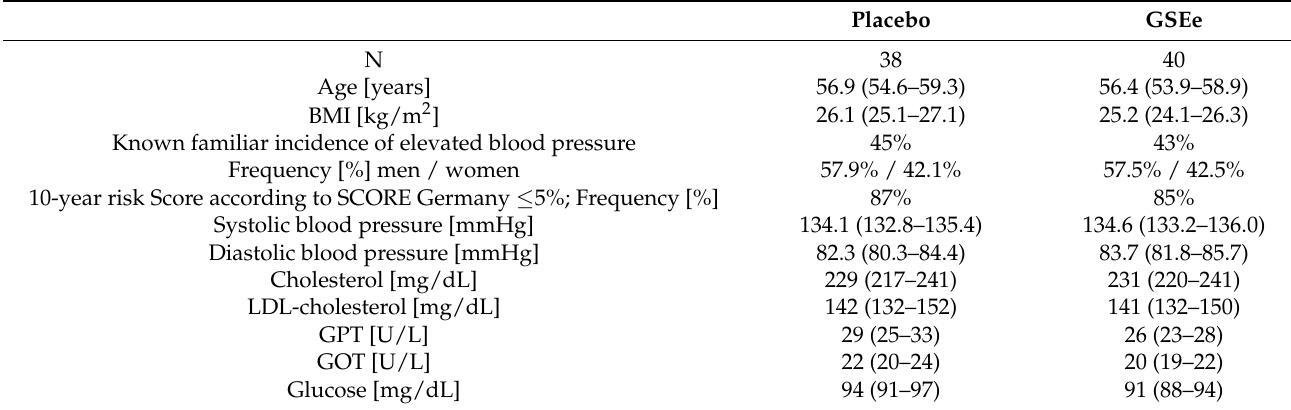
Table 1. Population characteristics, vital signs, and blood markers at baseline.